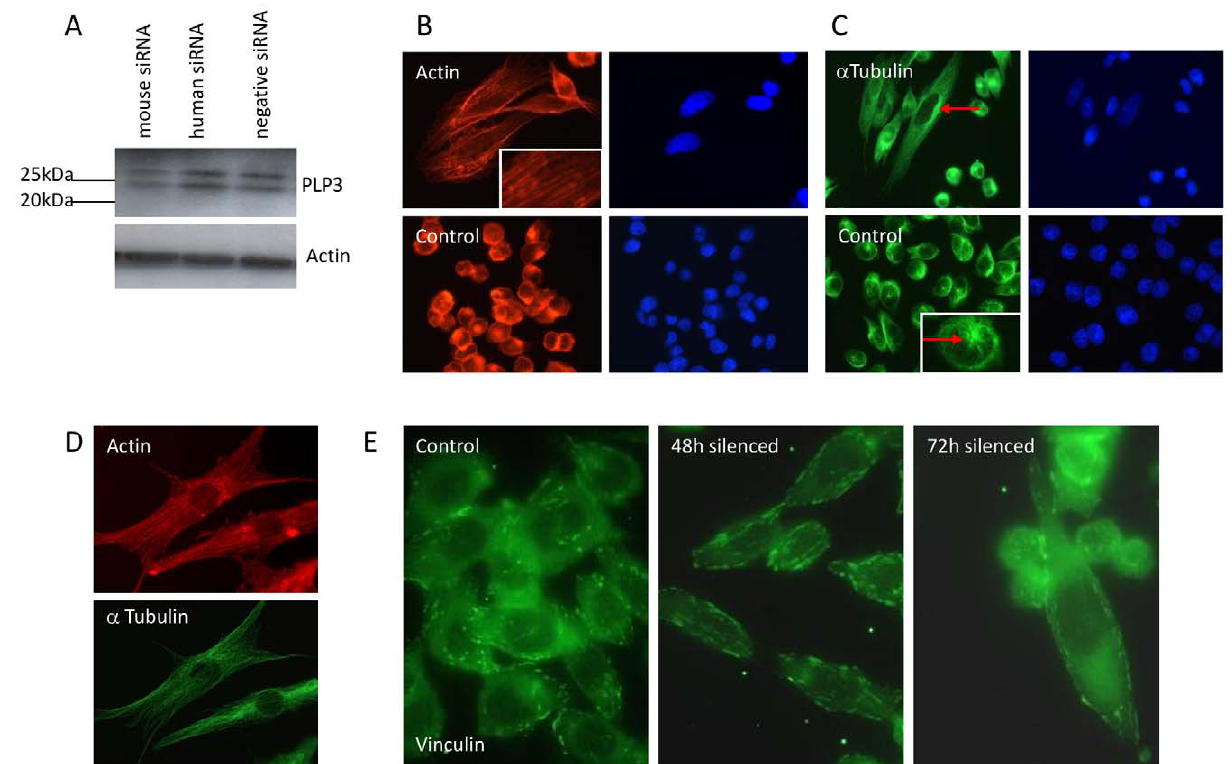
Figure 2. RNAi silencing of PhLP3 in LB01 cells promotes a fibroblast-like morphology and cytoskeletal rearrangement. (A) Immunoblots using anti-PhLP3 of LB01 cells transfected with mouse siRNA shows a decrease in PhLP3 expression compared to human siRNA and a scrambled negative control siRNA (top panel). Actin is used as an internal loading control (bottom panel). Note that two PhLP3 products (bands) are detected in these samples prepared with phosphatase inhibitors while in figure 1A (where they were absent) only one product is detected: PhLP3 is known to be phosphorylated [45] (see also references in the human PhLP3 Unigene entry UniGene Hs.536122) with the phosphoform displaying higher apparent molecular weight on SDS gels than the unphosphorylated form. (B) LB01 cells were transfected with mouse PhLP3 siRNA for 72 h and the cells were fixed and stained for either actin (rhodamine phalloidin) or (C) tubulin (anti- a -tubulin). The microtubule organising center is indicated by a red arrow. (D) NIH 3T3 mouse fibroblast cells were fixed and stained for F-actin filaments (rhodamine phalloidin, red) and microtubules (anti- a -tubulin, green). (E) Focal adhesions observed with anti-vinculin in cells transfected with the control plasmid or siRNA silencing plasmid 48 h and 72 h post